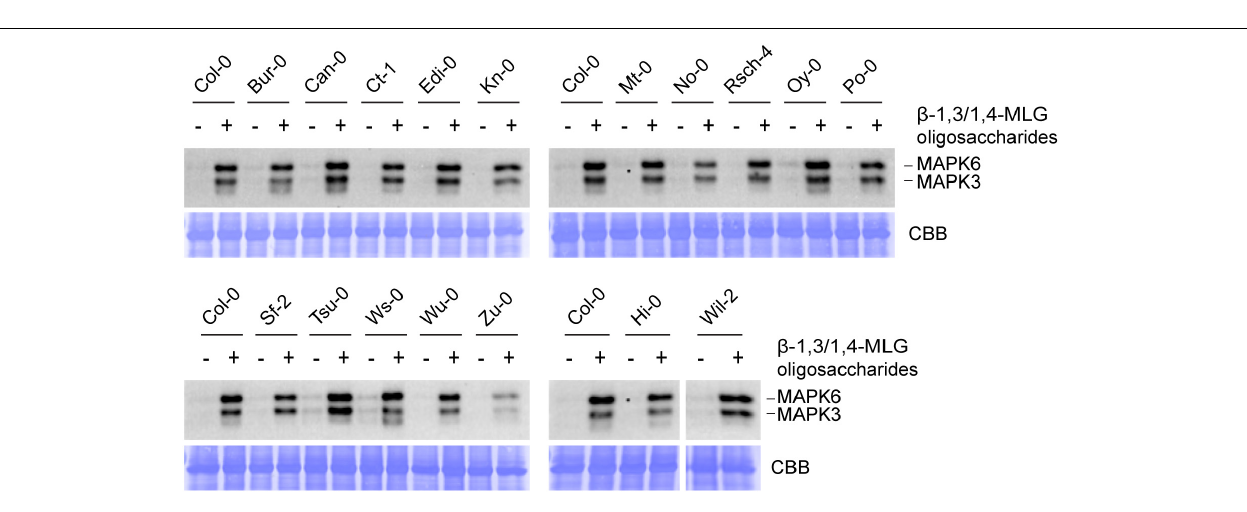
FIGURE 4 | Lichenase-generated β -1,3/1,4-MLG oligosaccharides induce MAPK activation in different Arabidopsis accessions. MAPK activation in 14-day-old seedlings of various ecotypes in response to enzymatically generated β -1,3/1,4-MLG oligosaccharides. β -1,3/1,4-MLG oligosaccharides were generated upon incubation of the MLG polymer (10 mg ml − 1 ) with the B. subtilis lichenase (1 U ml − 1 ) for 60 min ( Supplementary Figure 3 ). For the treatment, a 1:10 dilution of the hydrolysis products was used. Sodium phosphate buffer (1 mM) served as negative control. As loading control, the PVDF membrane was stained with Coomassie Brilliant Blue (CBB). Data show the result from one biological